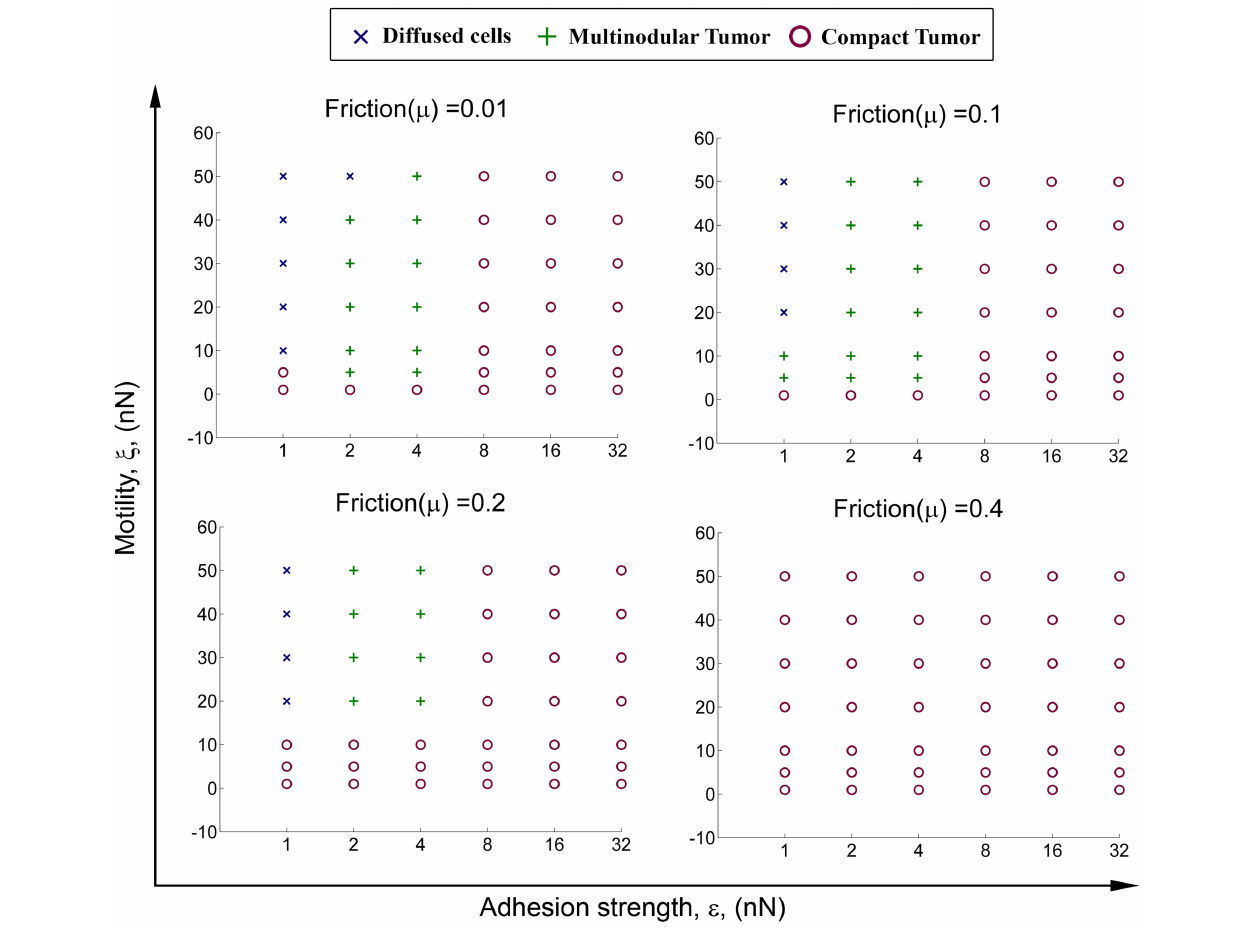
and cell–ECM adhesion result in a diffuse or multinodular tumor, whereas cells with low motility and high cell–cell and cell–ECM adhesion result in a compact tumor. In all of these simulations the rate of nutrient consumption λ is equal to 10.